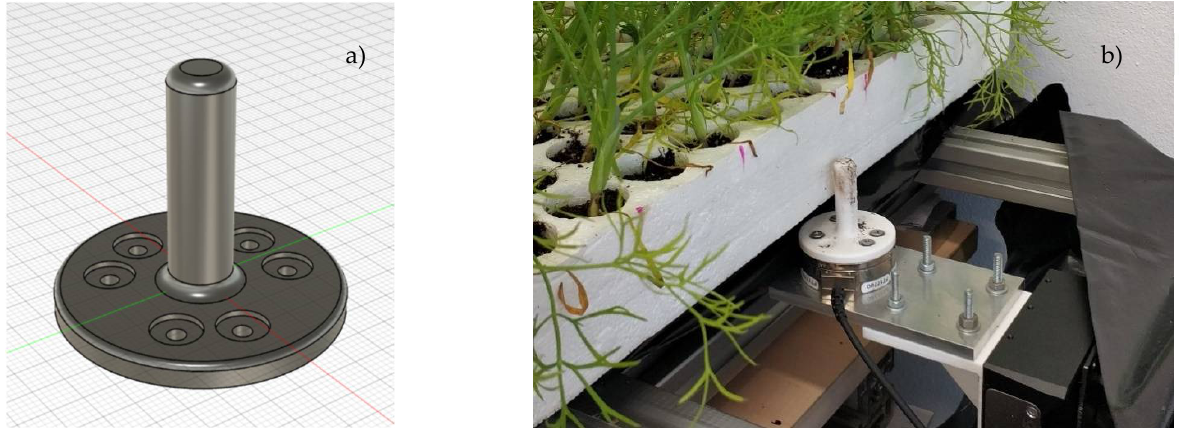
Figure 3. Punching experiment: a ) 3D model of puncher; b ) experimental setup with fennel seed- lings.